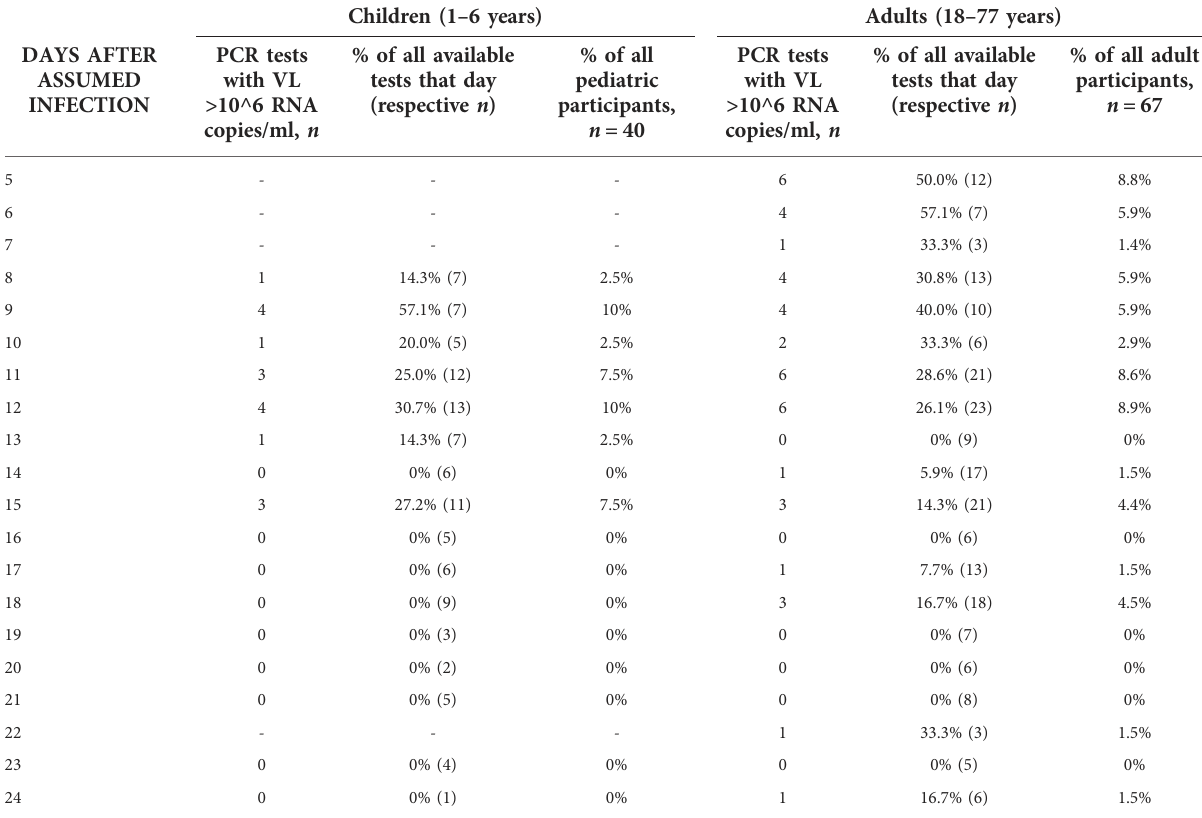
TABLE 1 Number and proportion of children and adults showing a viral load in the infectious range, detailed for different days of the infection course. Samples are not provided by all participants on each day, because (a) the sampling scheme asked participants to send in swabs every third day only, and (b) the sampling scheme started on day 4 – 6 after testing date of the index case, therefore participants were included on different days of their individual course of infection, and sampled over a period of 12 days. Dashes: no samples